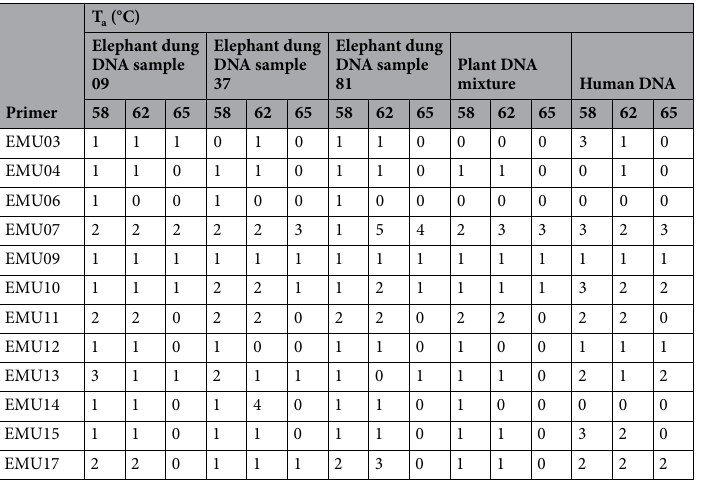
Table 2. Number of bands detected in primers with the variation of annealing temperature and DNA